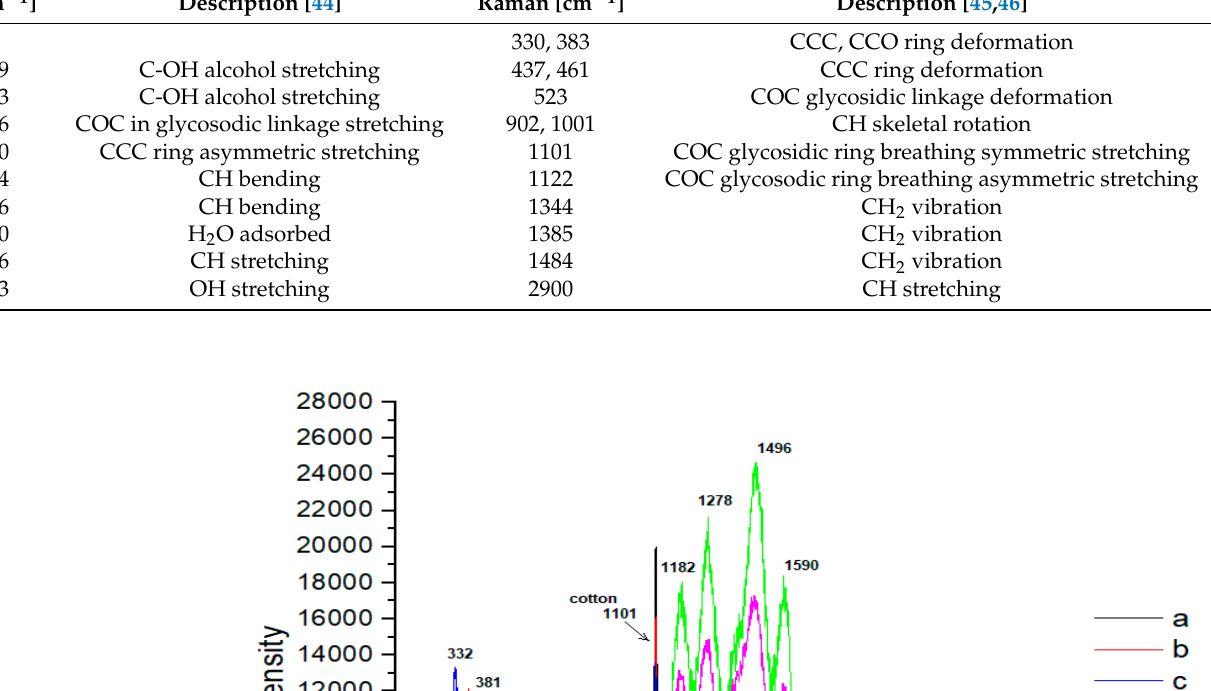
Table 1. IR and Raman characteristic bands of cotton.